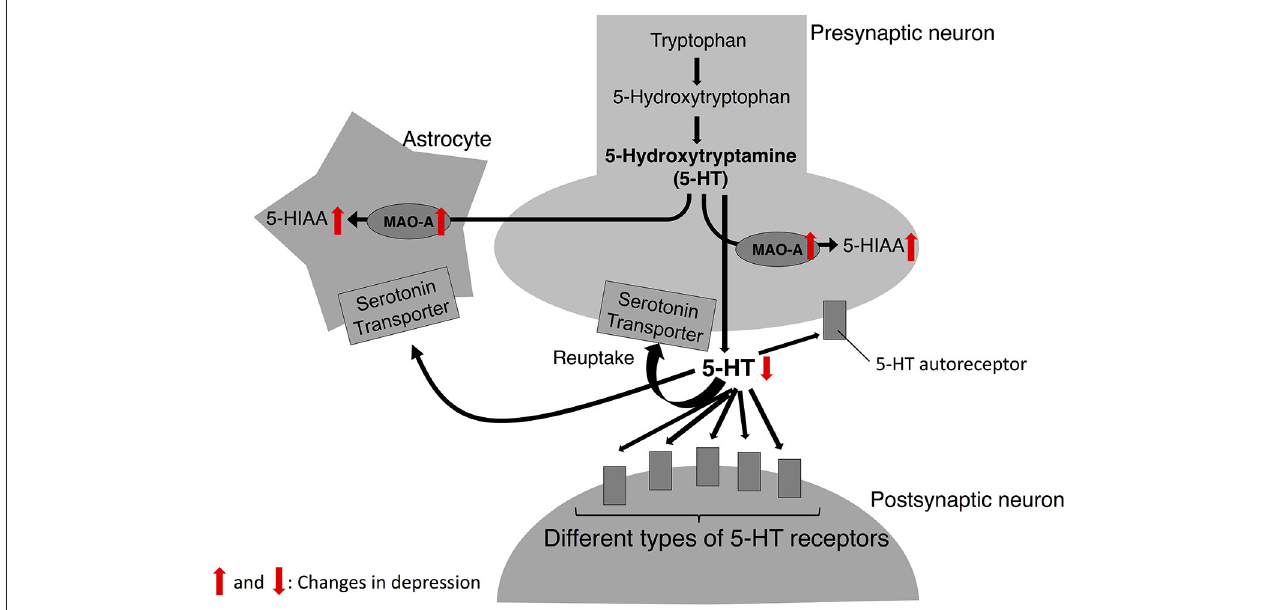
FIGURE 1 | 5-HT biosynthesis, release, and degradation. In serotonin theory of depression, the catalytic activity of MAO-A is upregulated in depression; thus, the levels of 5-HT released from 5-HT neurons are decreased while the levels of its metabolite, 5-HIAA are increased. Red arrows indicate the changes observed in